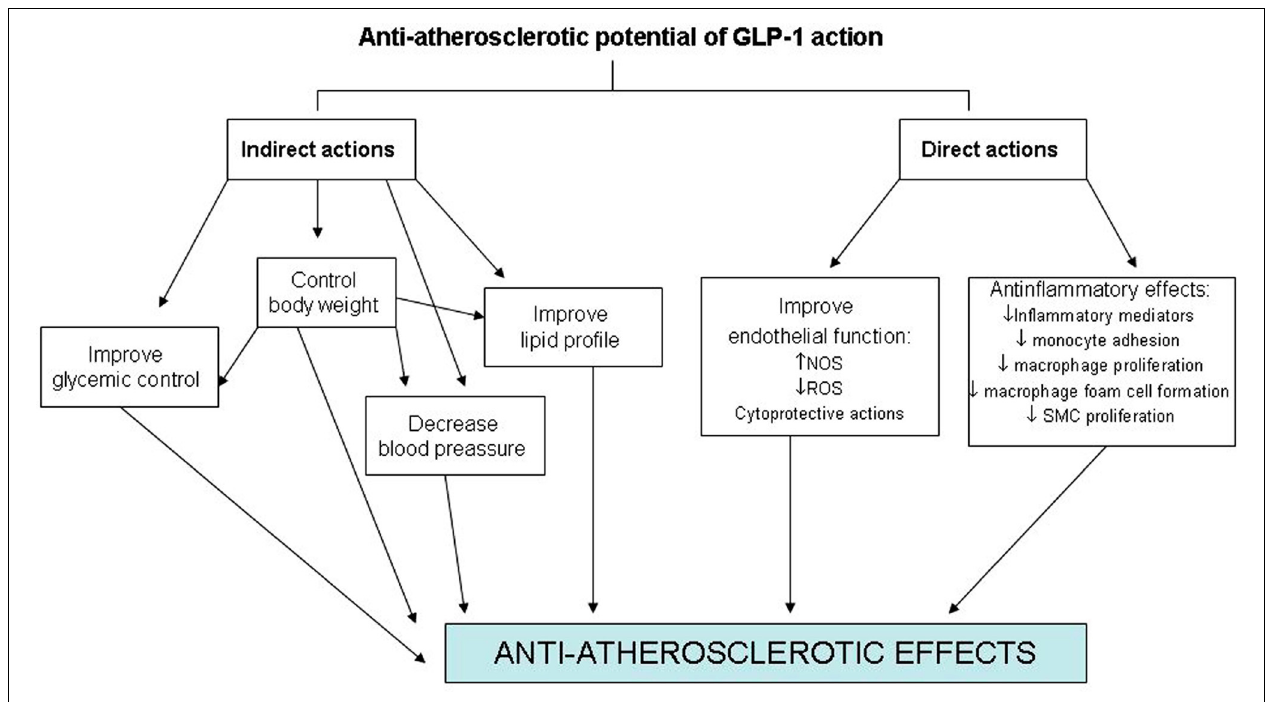
FIGURE 1 | Direct and indirect effects of GLP-1 on the cardiovascular